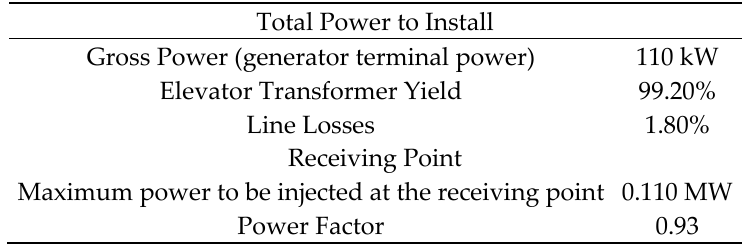
Table 2. Important data for the feasibility calculations of the installation